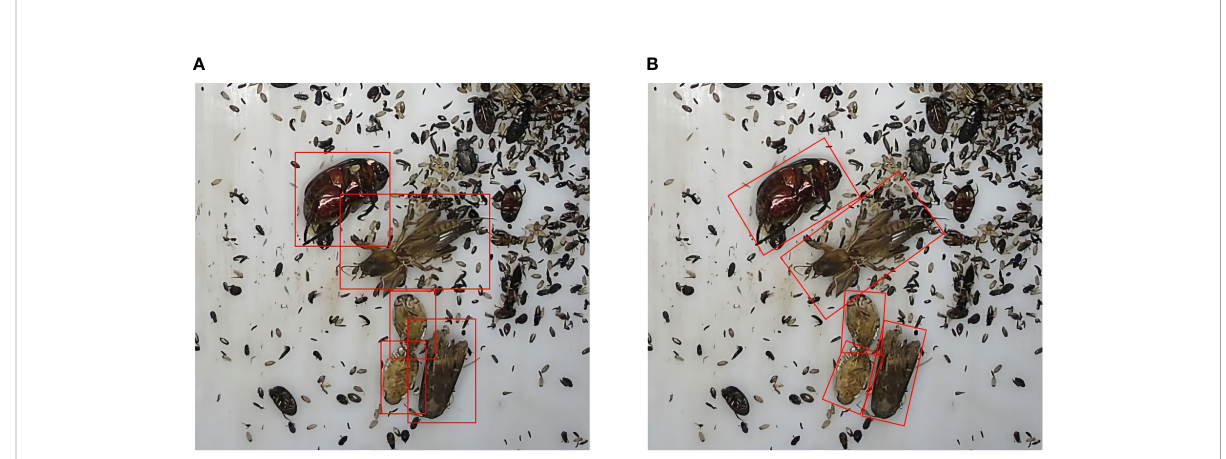
FIGURE 1 The training samples of horizontal algorithm and rotation detection algorithm are different. (A) is the horizontal frame More disturbed by other backgrounds, (B) is a rotating frame, which can better fi t pest